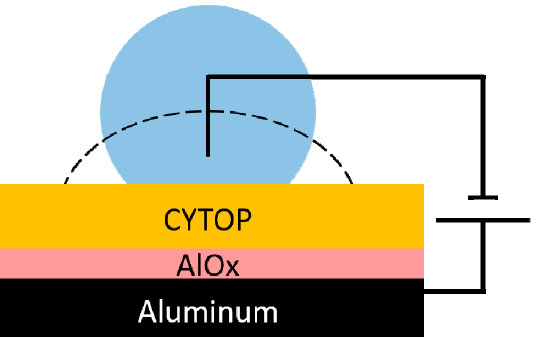
Figure 1. A schematic of the electrowetting on dielectric (EWOD) device used to assess changes in contact angle upon applying a voltage.